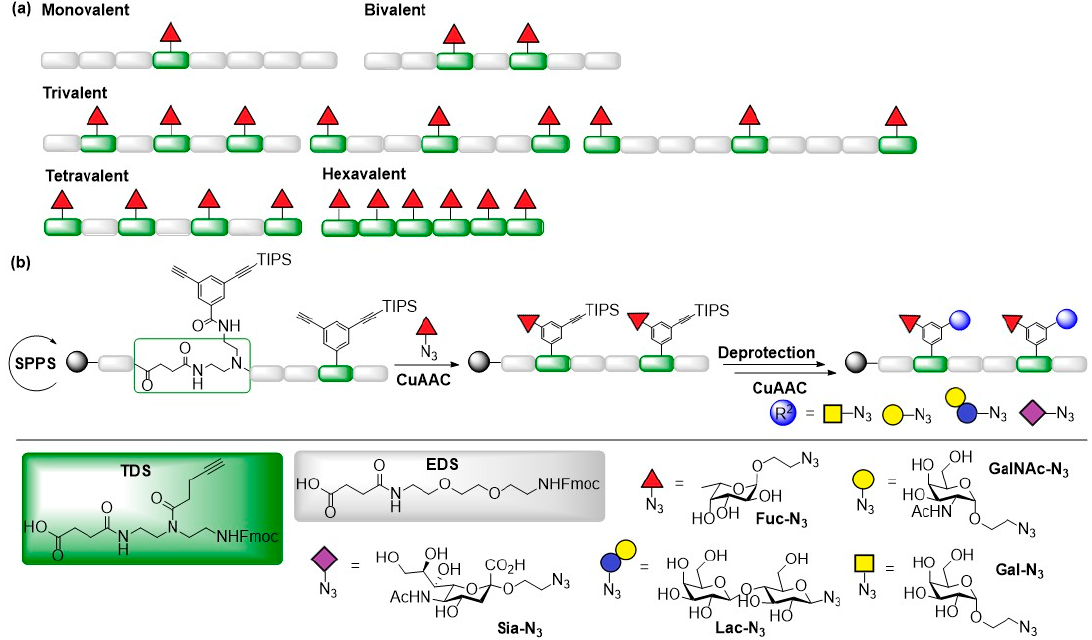
Figure 6. ( a ) Structure and preparation of building blocks TDS and EDS and fucosylated glycooligomers; ( b ) Synthesis of heteromultivalent glycooligomers with introduction of different carbohydrate ligands by consecutive CuAAC on solid support.